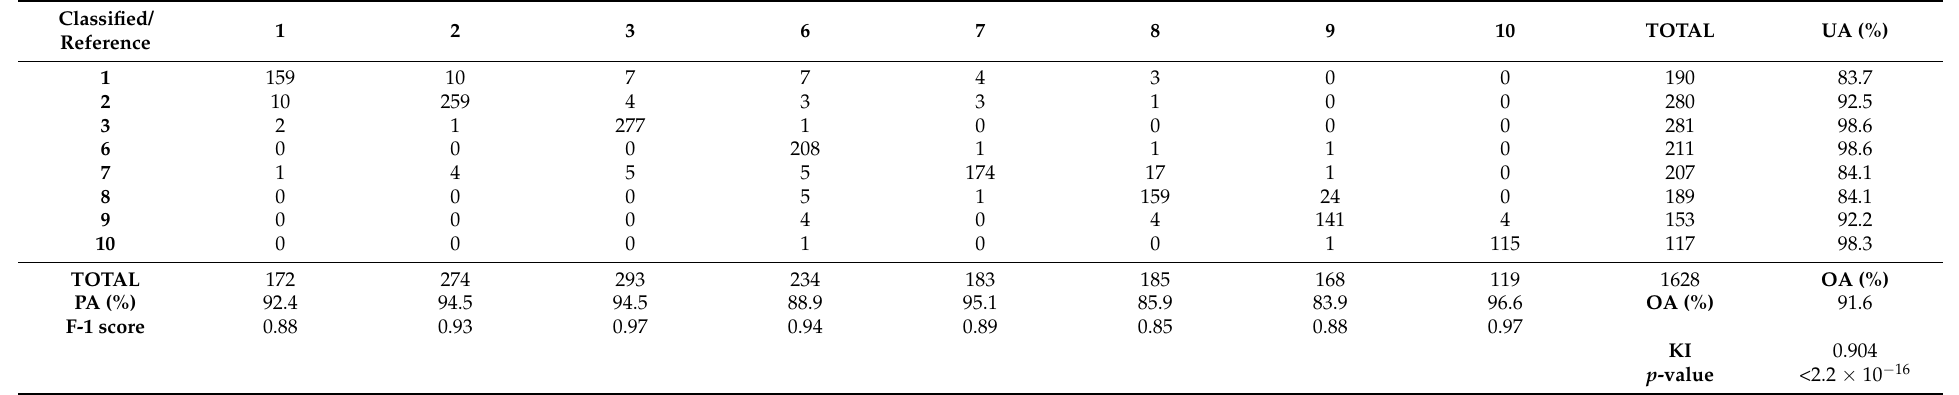
Table 10. Confusion matrix of the cross verification performed for the classification produced at 10 m to decide the optimal resolution for producing regional land cover maps. Obtained metrics: Users Accuracy (UA), Producer’s Accuracy (PA) and the Kappa Index (KI). Eucalyptus spp. (1), Conifers (2), Broadleaves (3), Crops and pastures (6), Shrubs (7), Bare soil (8), Anthropogenic areas (9) and Water